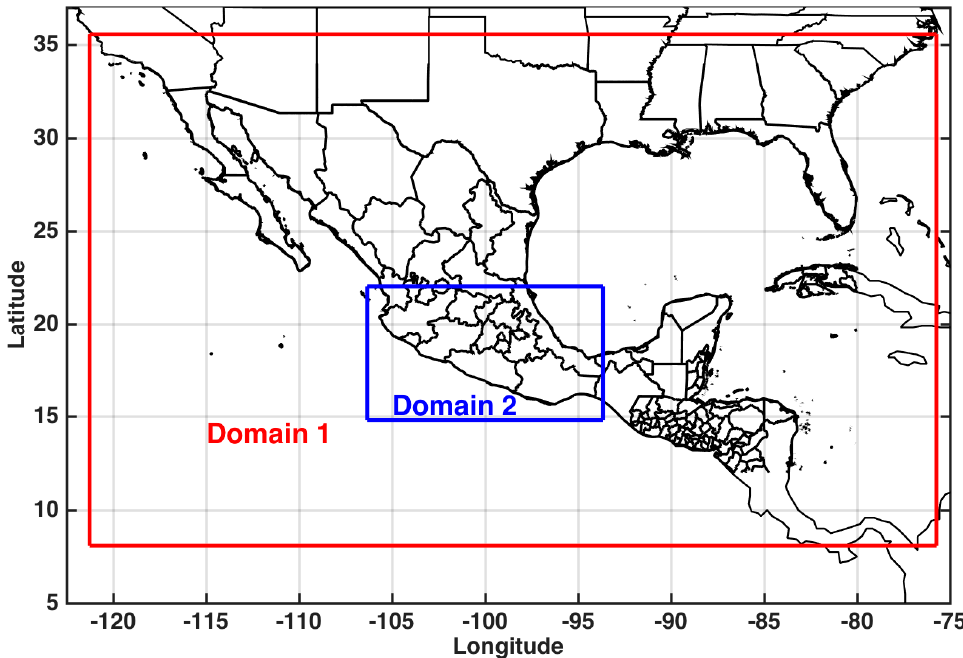
Figure 2. Domain of the simulations. The outer domain or Domain 1 ( red ) has a 20 km horizontal resolution and the nested domain or Domain 2 ( blue ) has a 6.7 km horizontal resolution.